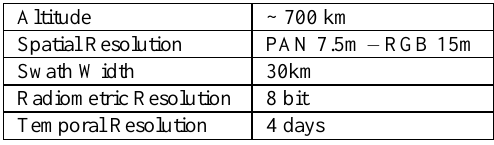
Table 1. Technical specifications of RASAT